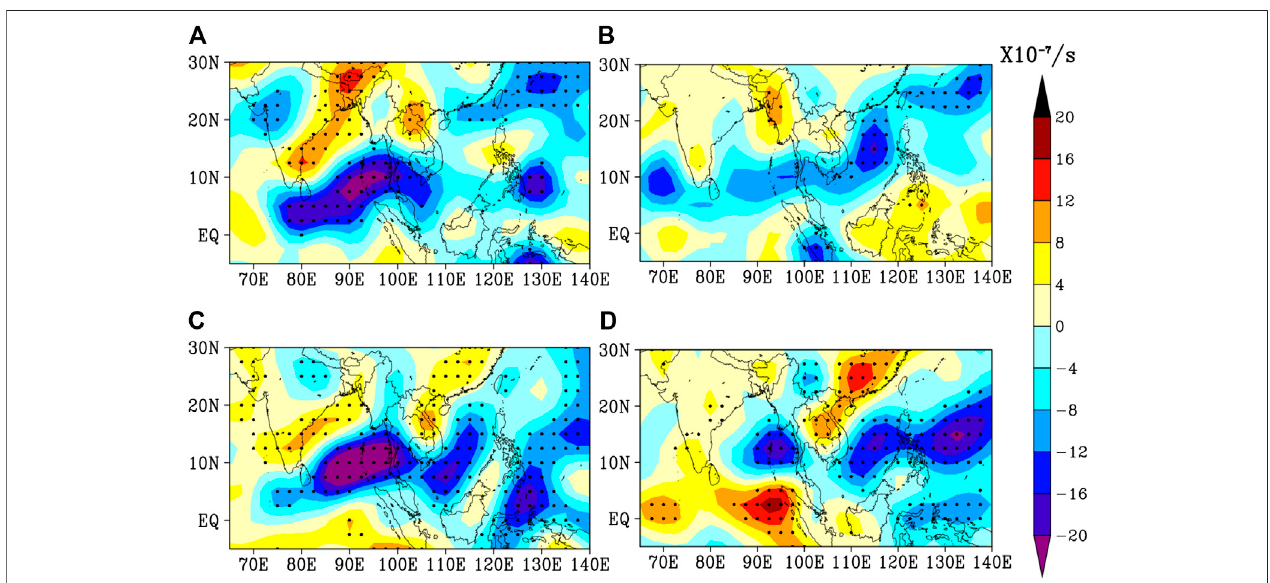
FIGURE 11 | Regression maps of the preonset divergence anomaly (shaded; unit: s − 1 ) at 150 hPa against the (left) BOBSM onset time and (right) SCSSM onset timefor (upper) 1958 – 1979and (bottom) 1980 – 2018.Thestipplingdenotesvaluesexceeding the90%con fi dencelevel.ThepreonsetstagesofBOBSMandSCSSM are pentads 22 – 24 and 25 – 27,